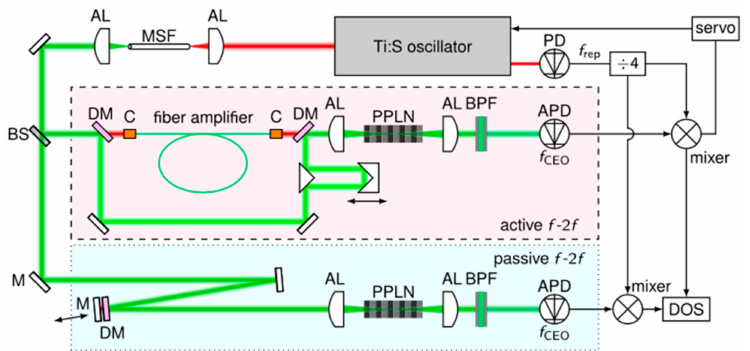
Figure 5. Setup of active f-2f interferometer. Reprint with permission from [100]. Copyright 2019 Optical Society of